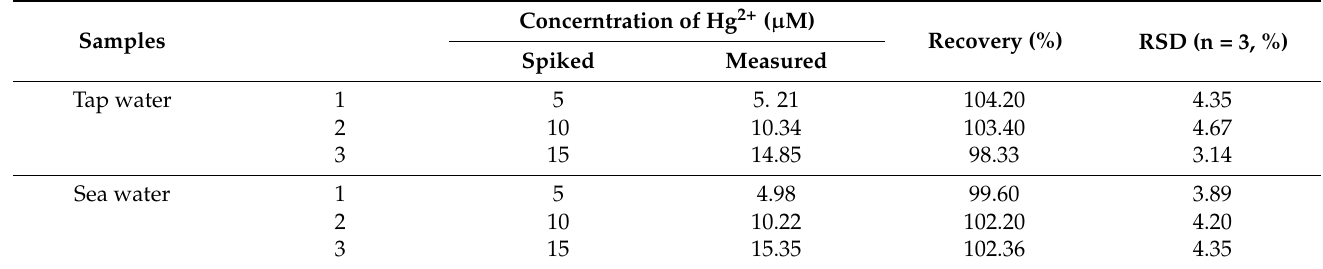
Table 1. Determination of Hg 2+ in tap water and sea water samples.